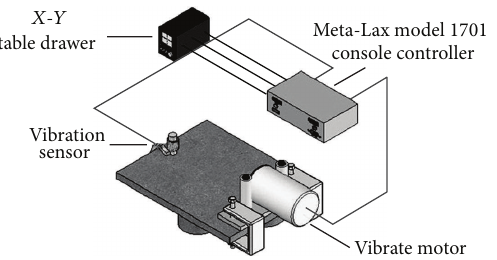
Figure 3: The oscilloscope examination system of the Meta-Lax.